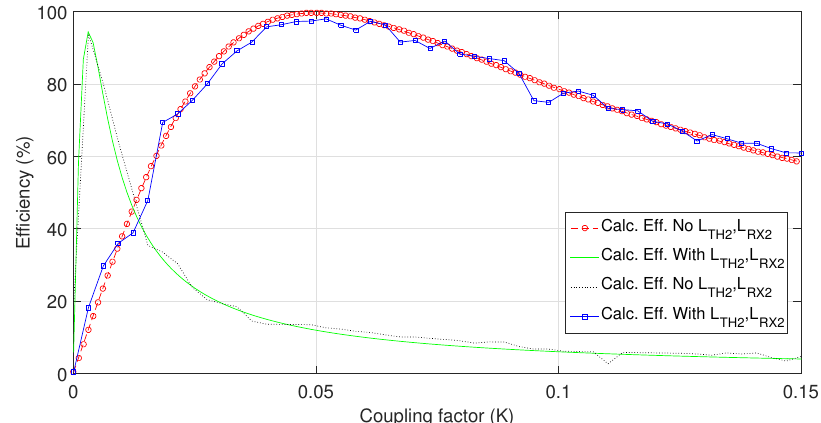
Figure 14. A comparison between the measured and calculated maximum distances between the low Q design coil with and without added inductor at frequency of 9.23 MHz. The system with an additional coils shows an increase in the distance between T X and R X at which mximum efficiency